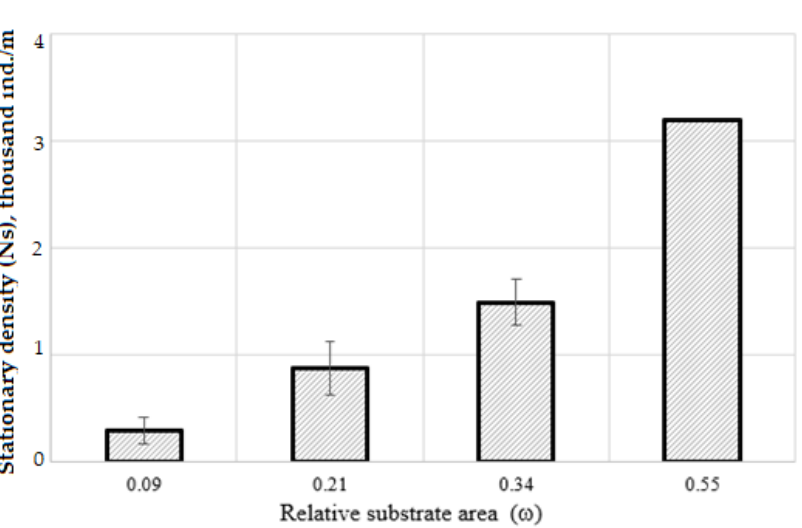
Figure 2. Relation between the relative substrate area ( ω ) and the average stationary density (N s ) on different types of collectors; (vertical lines are standard deviation.